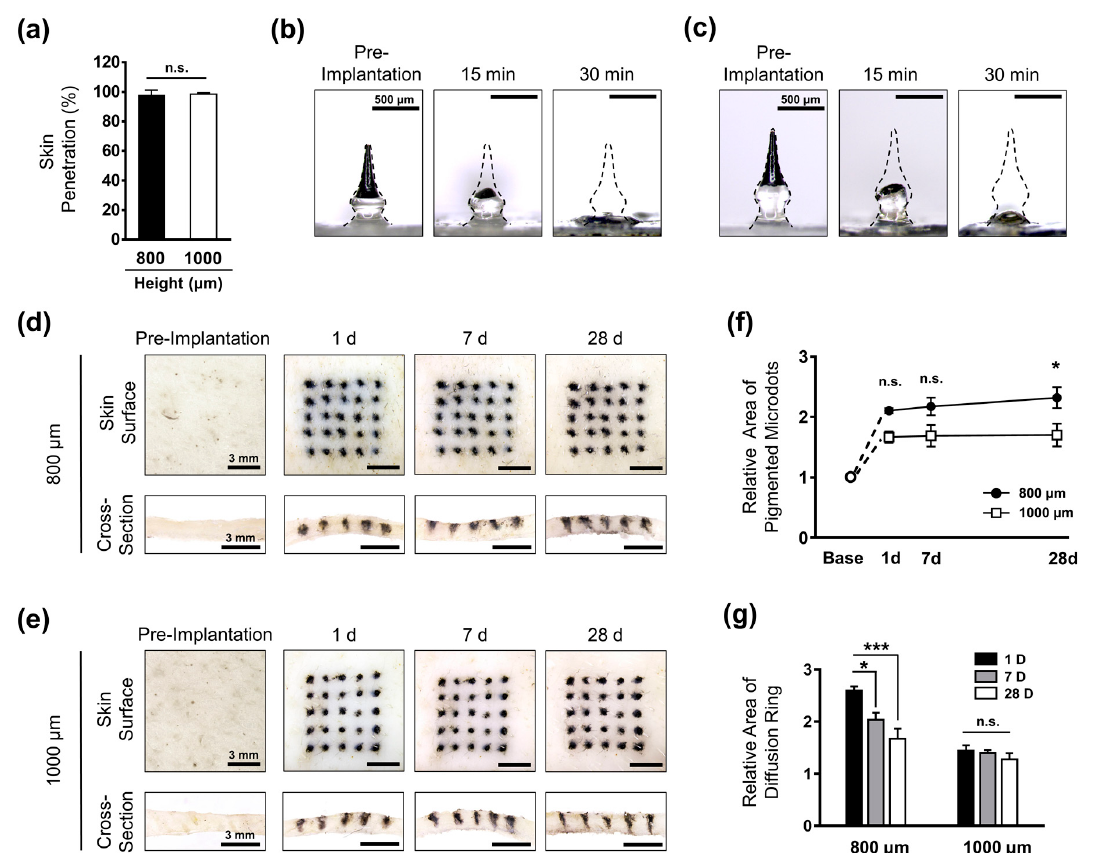
Figure 3. Transcutaneous analysis of micro-pigment-encapsulated biodegradable microneedles (PBMs). ( a ) Both 800 µ m- and 1000 µ m-long PBMs showed a high skin penetration success rate. ( b ) The micro-pigment-encapsulated top layer in both the 800 µ m-long PBM and ( c ) 1000 µ m-long PBMs were dissolved at 15 min post-implantation. At 30 min, the unpigmented primary layer was completely dissolved. ( d ) Implantation of 800 µ m-long PBM into the pig cadaver skin resulted in the formation of a large diffusionringon theskinsurface(upperpanels). The cross-sectionof skinconfirmedthelocalizationof the micro-pigment up to 28 days (lower panels). ( e ) The diffusion ring in the 1000 µ m-long PBM-implanted skin was barely visible. The dimension of microdots was highly maintained up to 28 days (upper panels). Cross-section images revealed a sharper localization of micro-pigments compared with the 800 µ m-long PBM-implanted skin. ( f ) Comparison of microdots confirmed the well-maintained micro-pigmentation in the 1000 µ m-long PBM-implanted skin up to 28 days. ( e ) The diffusion ring was significantly reduced over time in the 800 µ m-long PBM-implanted skin. Data in ( a , f , g ) are expressed as the mean ± SEM. * p < 0.05, and *** p <